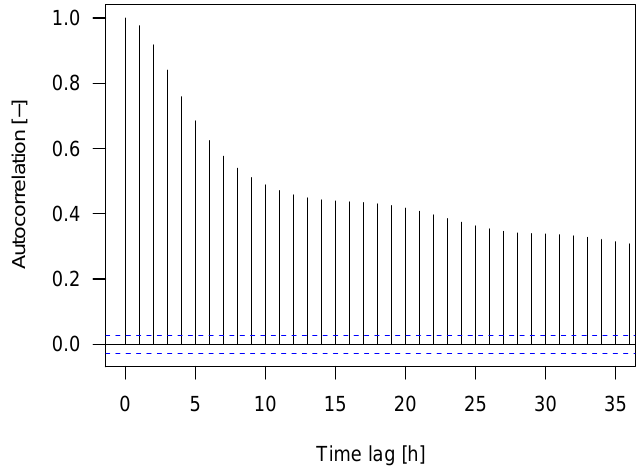
Figure 10. Discharge autocorrelation at the catchment outlet calculated for the calibration and validation period. Horizontal blue lines indicate the autocorrelation significance